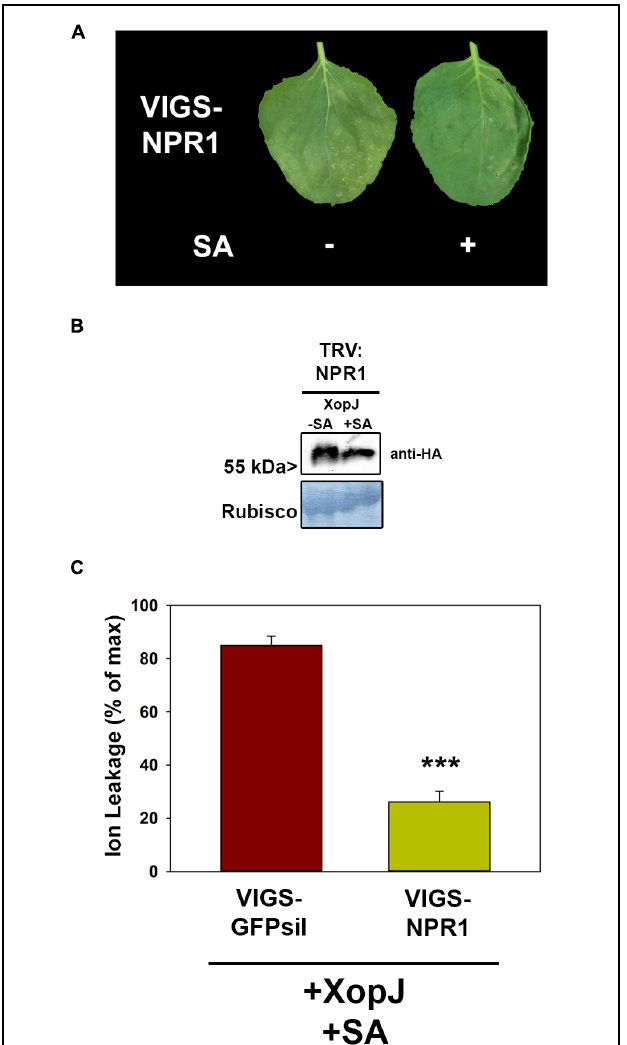
FIGURE 4 | VIGS of NPR1 prevents XopJ induced HR-like cell death after SA treatment. (A) XopJ was transiently expressed in NPR1 silenced plants and treated with 5 mM SA 24 hpi. Leaf phenotypes were photographed 48 hpi. (B) Protein extracts from TRV:NPR1 leaves transiently expressing XopJ-HA treated with or without 5 mM SA. Amido black staining served as a loading control. (C) Ion leakage was determined in TRV:NPR1 and TRV:GFPsil plants transiently expressing XopJ following SA treatment. Bars represent the average ion leakage measured for triplicates of six leaf155 disks each, and the error bars indicate SD. Significant differences are indicated by asterisks ( ∗∗∗ P < 0.001). The experiment was repeated three times with similar